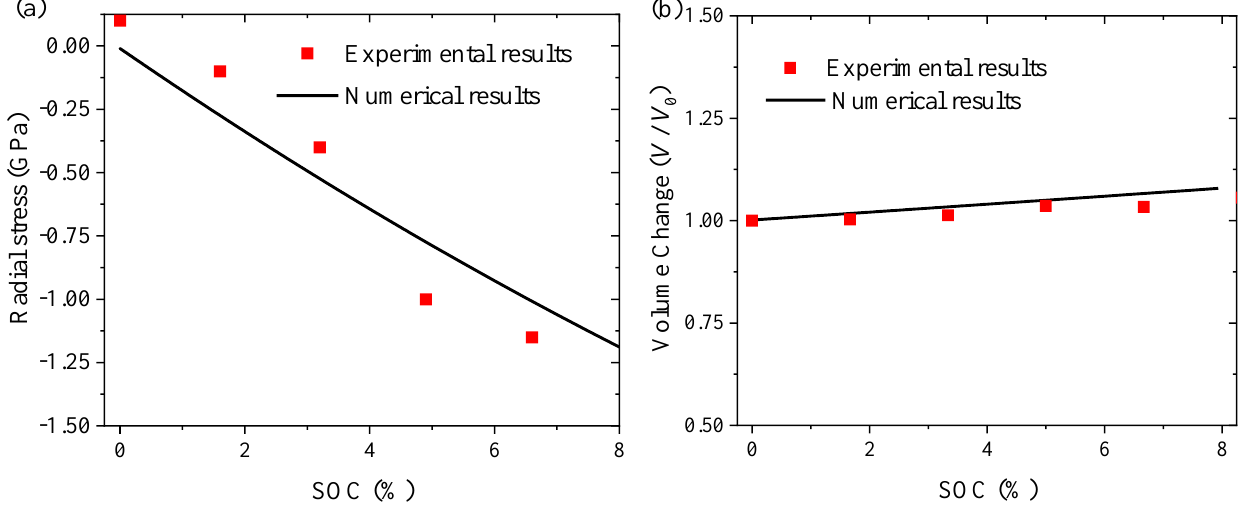
Figure 9. Variations of ( a ) radial stress at the center of the top surface, and ( b ) the volumetric change of the Si thin film with SOC at stage I. (Total C-rate: C/14).